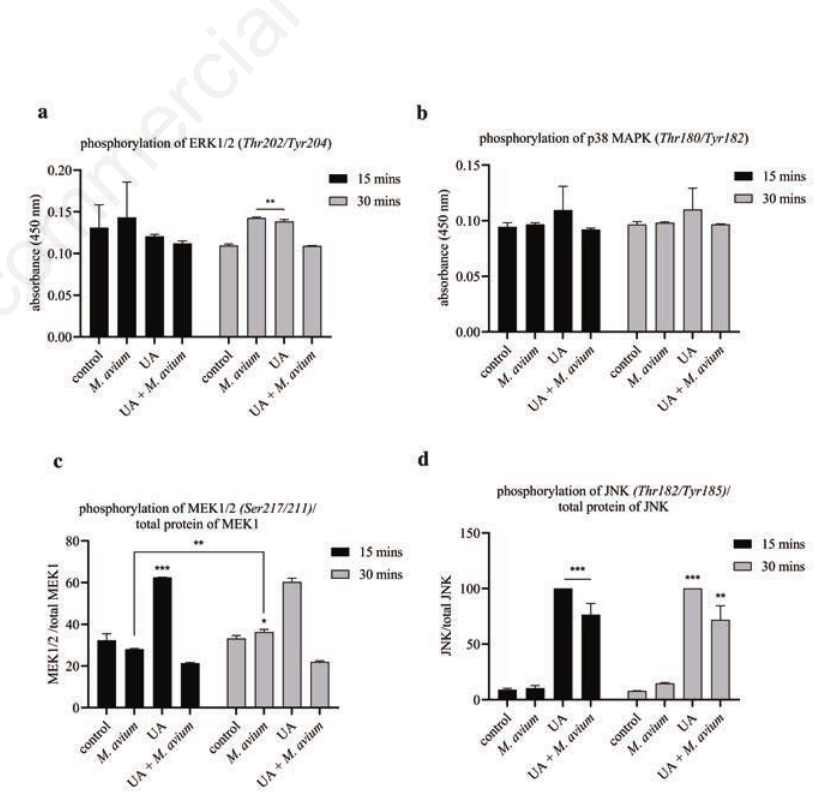
Figure 5. Nuclear protein absorbance in the experimental group in 15 and 30 min, con- sisting of (a)ERK1/2 MAPK phosphorylation, (b)phosphorylation of p38 MAPK, (c)rel- ative phosphorylation of MEK1/2 to the total protein of MEK1, and (d)relative phos- phorylation of JNK to the total protein of JNK. The results are described as mean of ±SD, with each performed in triplicate; ****p<0.0001; ***p<0.001; **p<0.01;